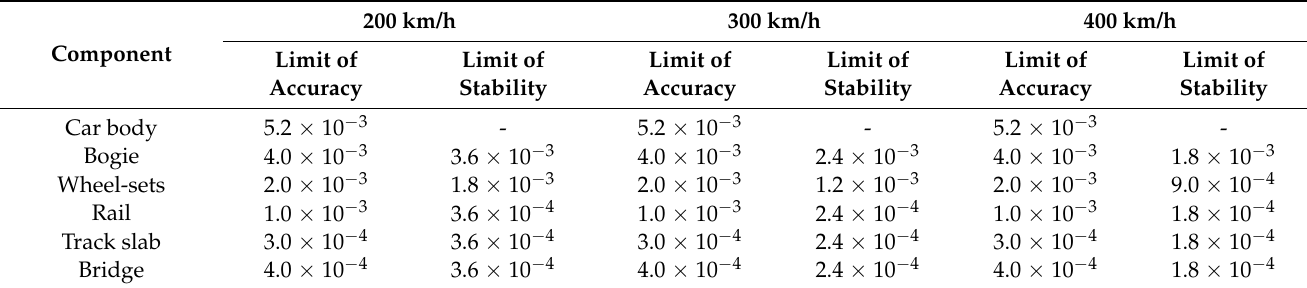
Table 5. Maximum of the Integration Time Step for Each Component at Different Speeds (unit: